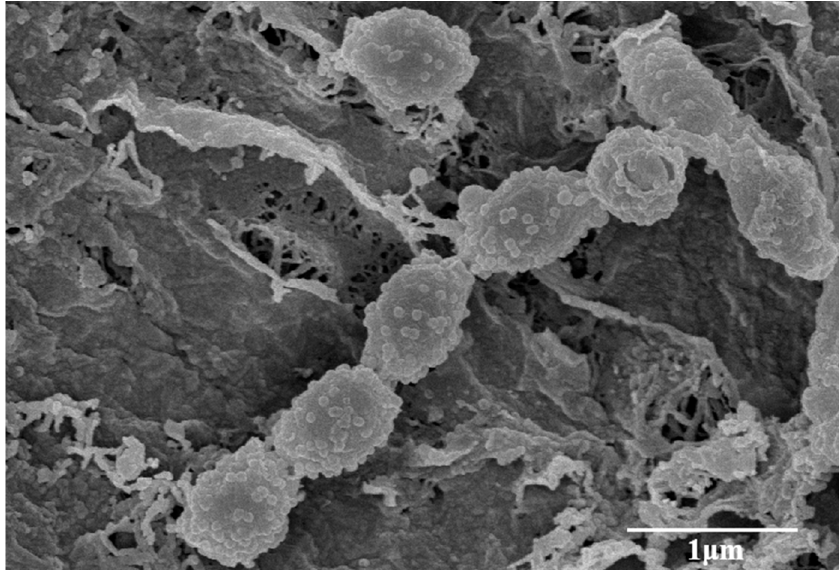
Figure 3. Scanning electron micrograph of strain LD120 T grown on International Streptomyces Project (ISP) medium 3 agar for 4 weeks at 28 °C. Bar 1 µm. Table 1. Differential characteristics of strain LD120 T and its closely related strains.